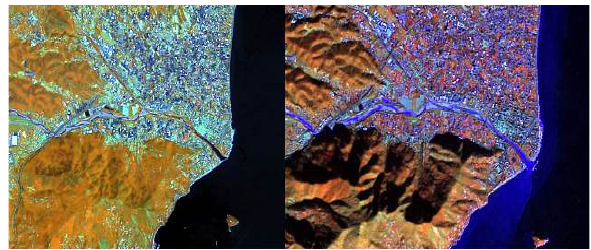
Figure 2. Town of Albenga and delta of Centa River seen in SWIR- NIR - red pseudo colour composite that enhances the difference between land and water bodies in May (left) and Nov 2016